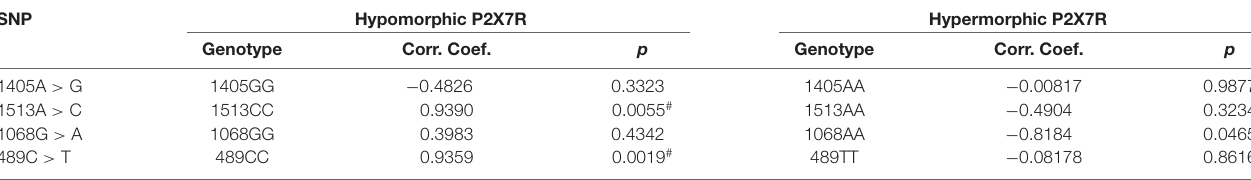
TABLE 4 | Correlation analysis of P2XR7 genotype frequency with age decade.